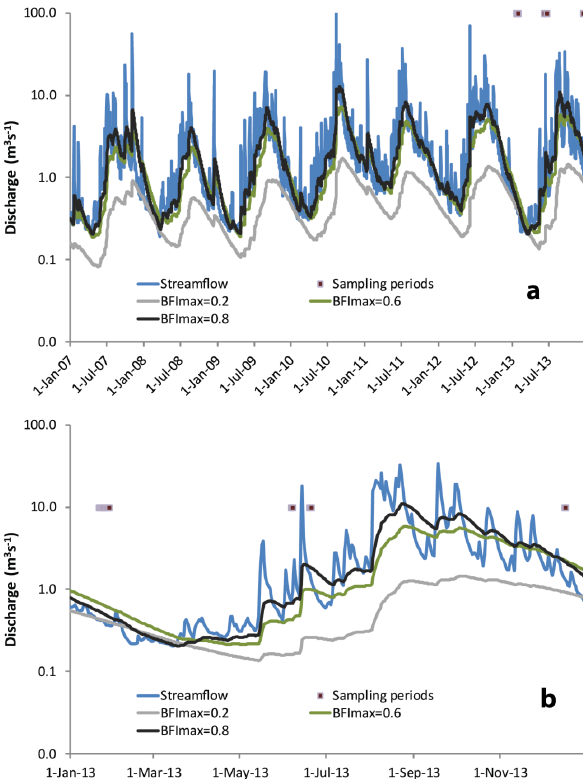
Figure 2. Hydrograph at Bunker Hill gauging station (235227) il- lustrating the seasonality of flow. Three baseflow separation hydro- graphs generated using different BFI max parameter values (0.20, 0.60, 0.80 and a = 0 . 988) for the Eckhardt filter are displayed, along with the periods of hydrochemical sampling of streamflow during 2013.